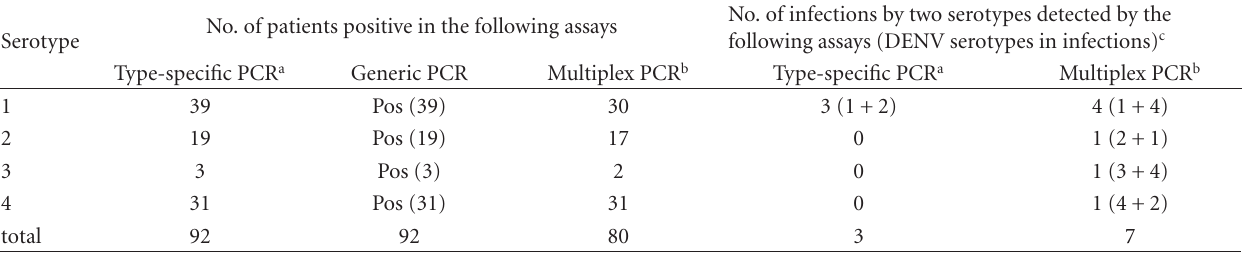
Table 7: Serotyping by multiplex real-time PCR with serotype-specific probes.